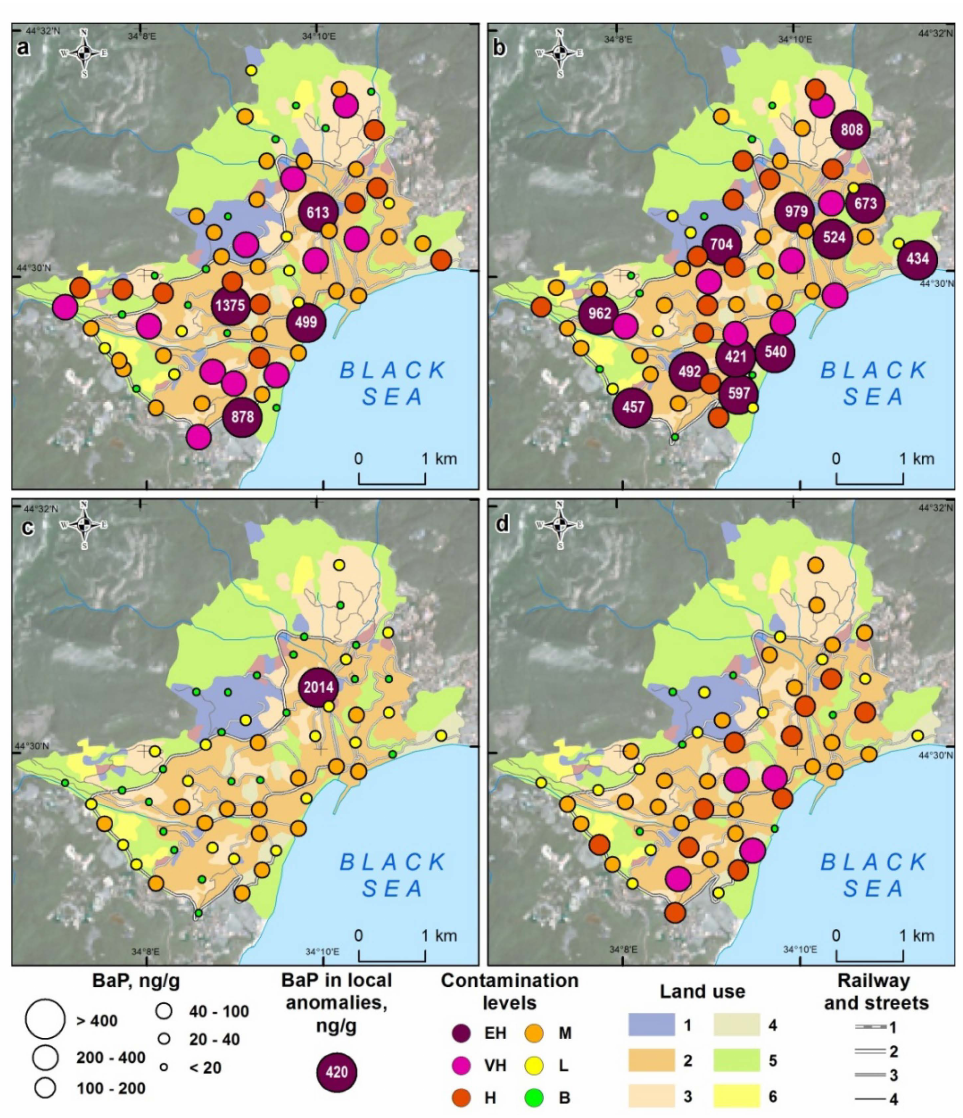
Figure 4. Distribution of BaP in soils ( a ) and their PM 10 particles ( b ), road dust ( c ) and its PM 10 particles ( d ) within the territory of Yalta. Contamination levels: EH—extremely high, VH—very high, H—high, M—moderate, L—low, B—background. Land use zones: 1—industrial, 2—multi-storey residential, 3—low-rise residential, 4—residential and recreational, 5—agrogenic, 6—recreational. Railway (1) and streets with: 2—large roads, 3—medium roads, 4—small